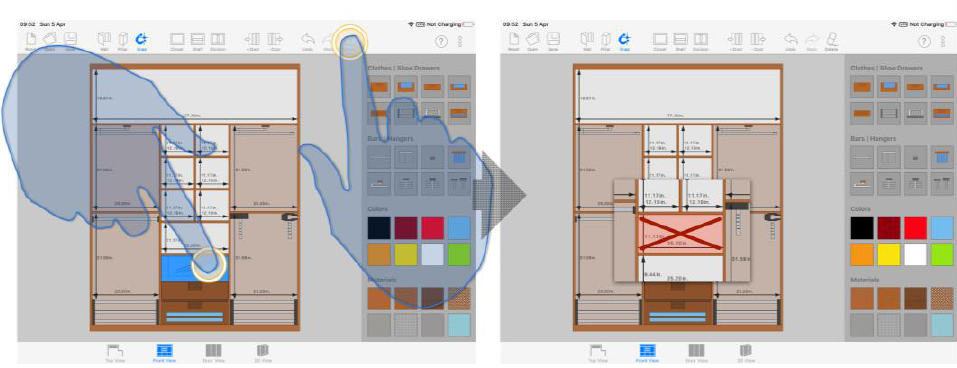
Figure 6. Deletion of an element from the design.